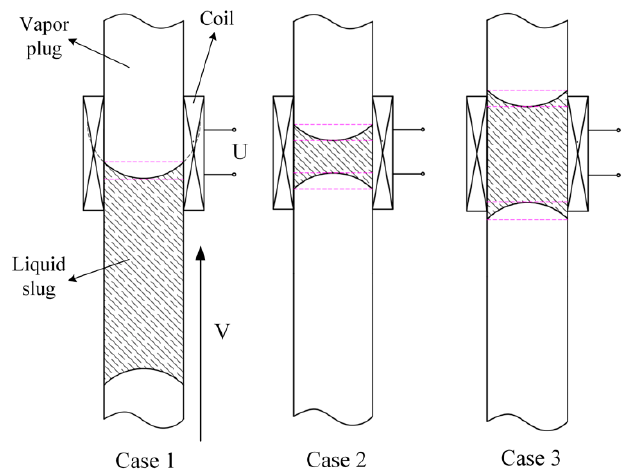
Figure 3. Three situations in which a liquid slug passes through a single coil.